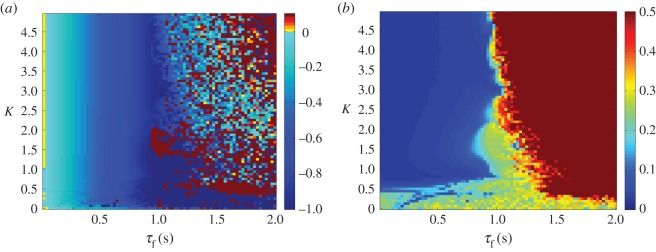
Lag (a) and lag-adjusted RMSE (b) between xtarget and xeffector, plotted as a heat map. τ is set to 0 s, while τf is varied between 0.01 and 2 s. The anticipation (seen as negative lag) closely matches τf within a near-rectangular region bounded by K>1 and τf<1 s, while at higher delays tracking no longer occurs and lag cannot be accurately measured. For this reason, the error is saturated at 0.5.